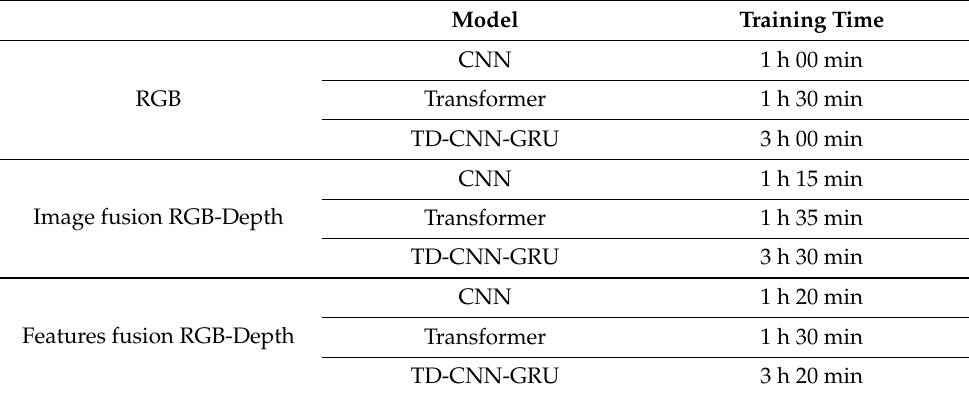
Table 5. Training time of the different deep learning architectures.